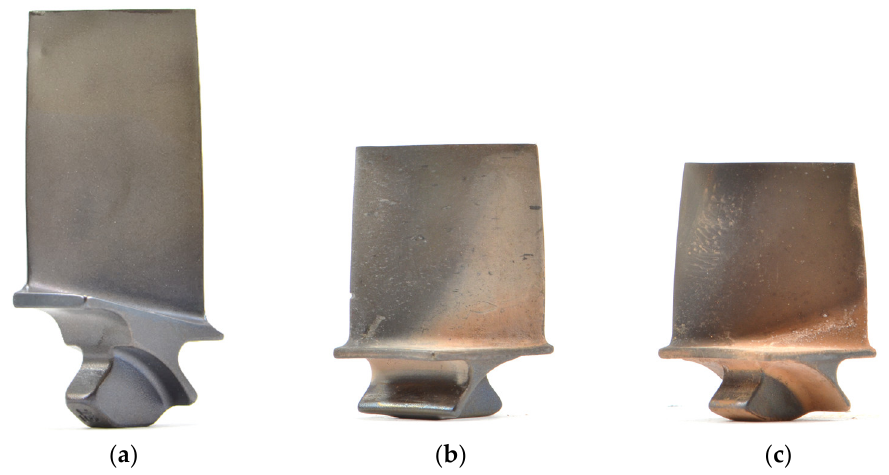
Figure 2. Sample blades: ( a ) airfoil dent, ( b ) nick on leading edge, ( c ) non-defective. There is a variety of different defect types and manifestations thereof that can occur.